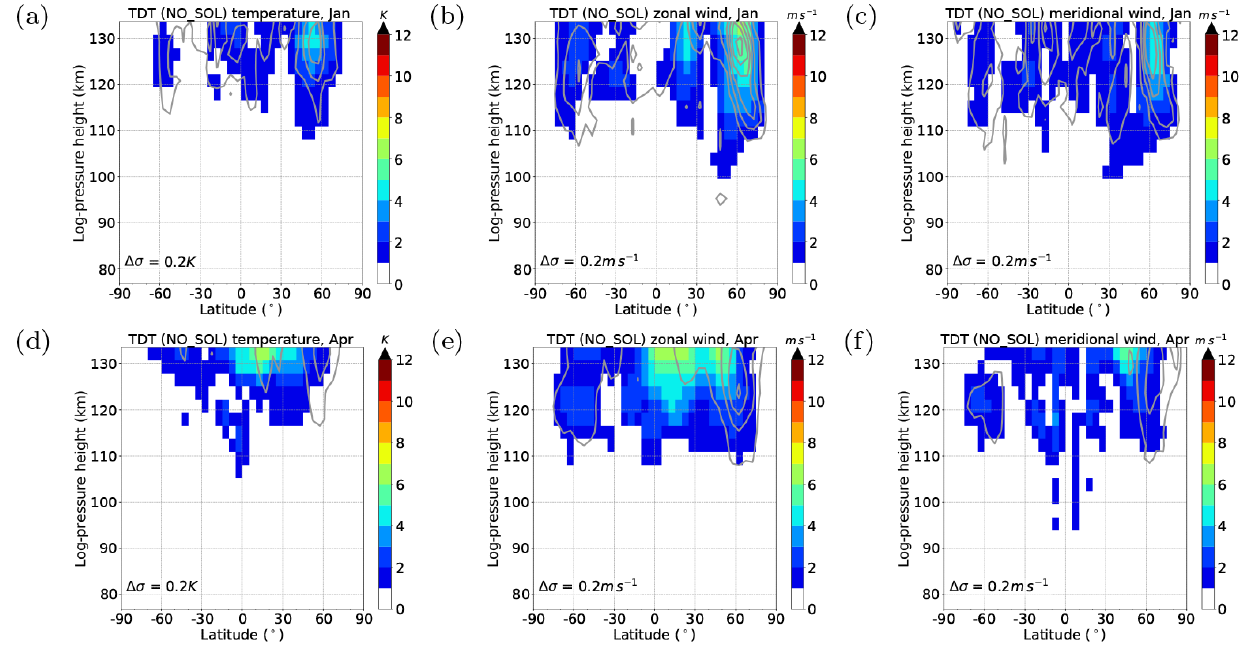
Figure 8. As in Fig. 5 but for NO_SOL simulation.